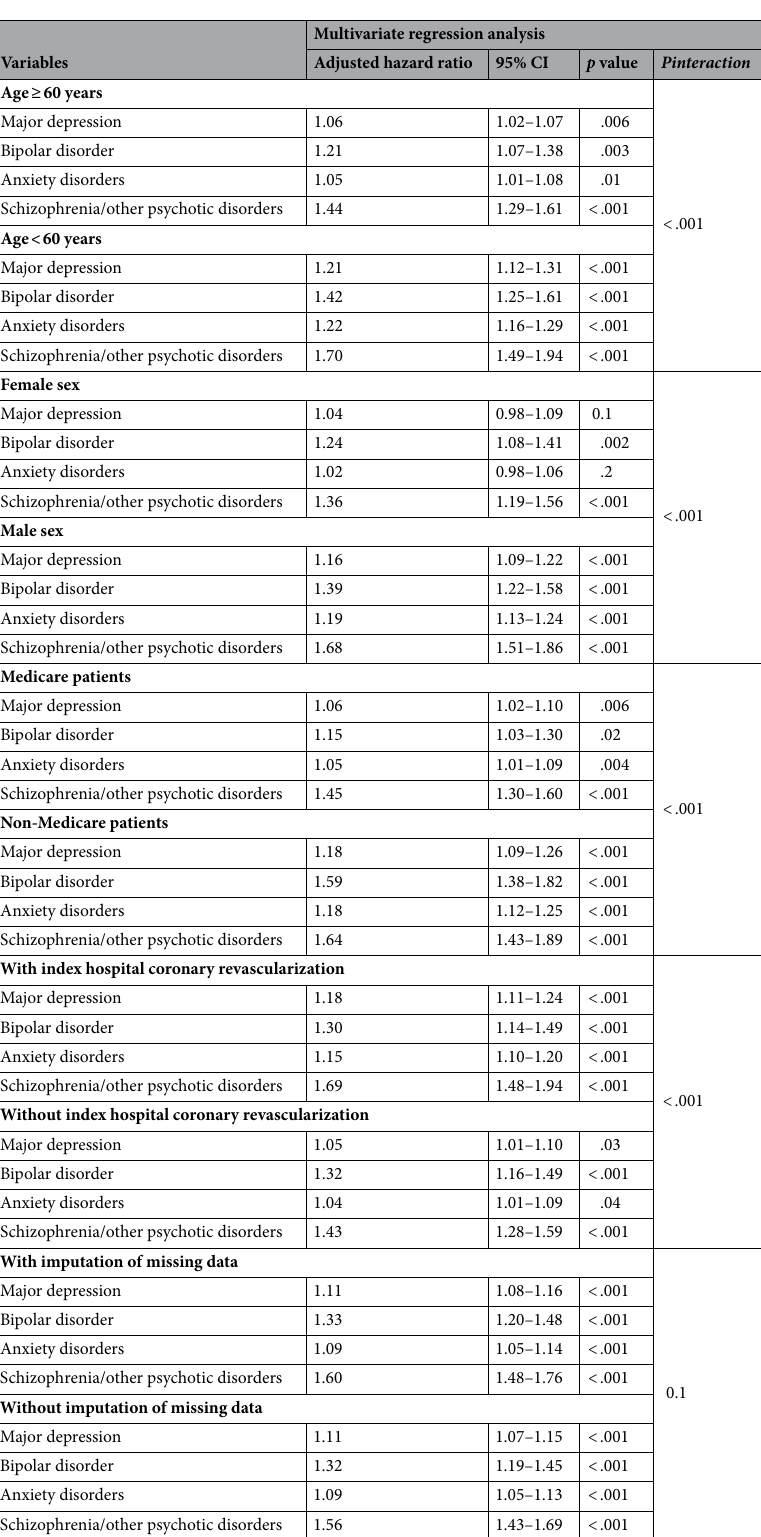
Table 3. Sensitivity analyses by specific sub-groups for the association of hospital readmission after acute myocardial